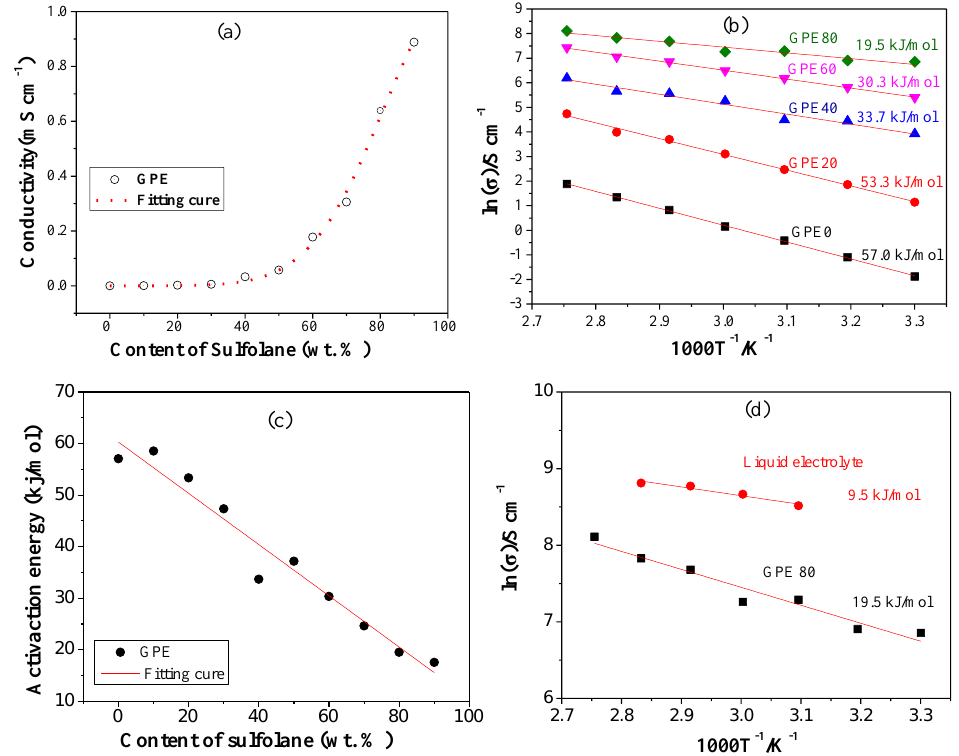
Figure 3. ( a ) The ionic conductivity of GPE changes with the content of sulfolane at 30 °C; ( b ) the relation between Log(σ) and 1/T of GPE; ( c ) change of activation energy with sulfolane content; and ( d ) the relation between Log(σ) and 1/T of liquid electrolyte.